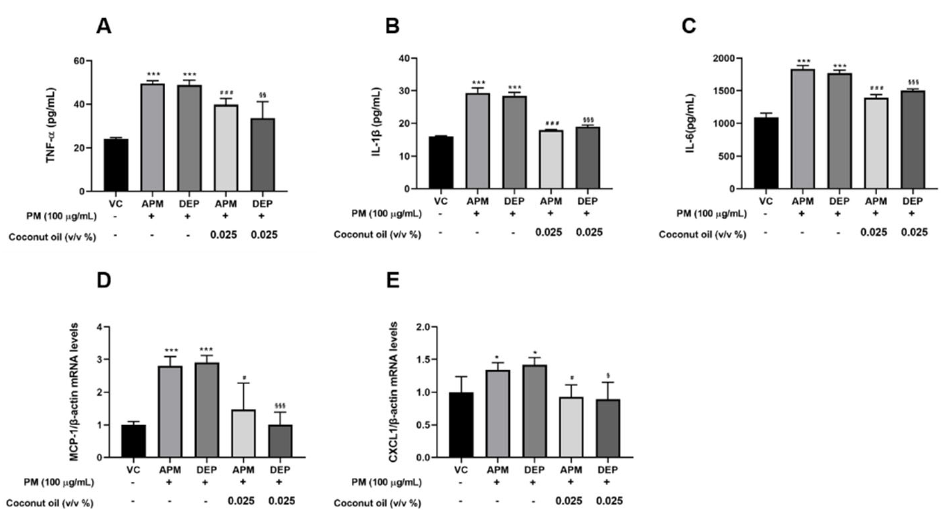
Figure 4. Effects of coconut oil on artificial particulate matter (APM) and diesel exhaust particles (DEP) − induced inflammation in alveolar macrophages (MH − S). Protein levels of ( A ) tumor necrosis factor −α (TNF −α ), ( B ) interleukin (IL) − 1 β , and ( C ) IL − 6 in MH − S were determined using enzyme − linked immunosorbent assay (ELISA). ( D , E ) Relative gene expression of inflammatory factors in APM/DEP–stimulated MH − S cells. Vehicle control (VC) was treated with cell medium including 10% distilled water. All experiments were independently performed in triplicate. * p < 0.5 or *** p < 0.001 vs. VC; # p < 0.05 or ### p < 0.001 vs. APM; § p < 0.05 or §§ p < 0.01, §§§ p < 0.001 vs. DEP.